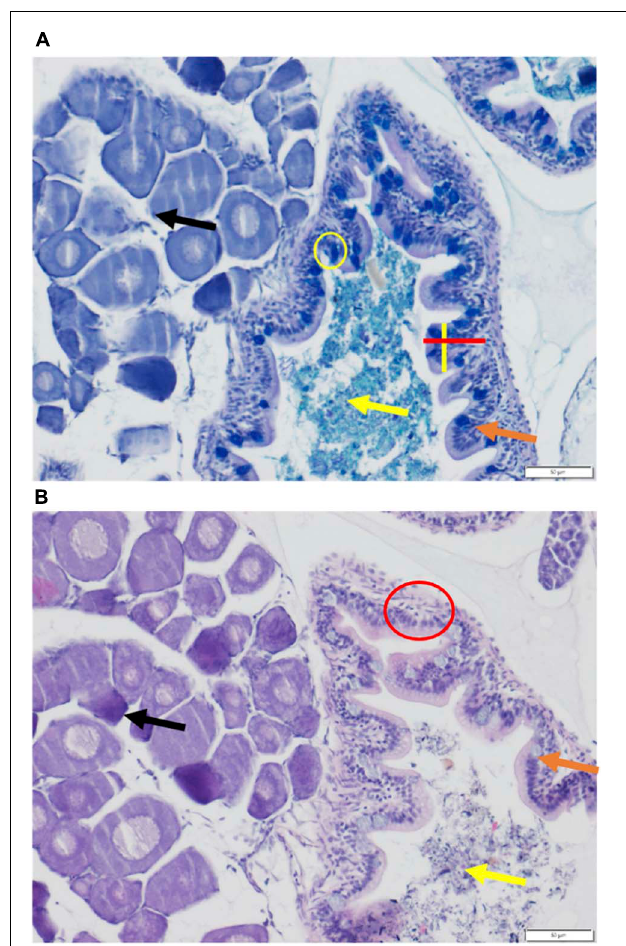
FIGURE 2 | Stained histological sections of control (0 fibers/fish/day) larval medaka hindgut. (A) AB-PAS stained hindgut. Red line indicates a measurement of microvilli length. Yellow line indicates a measurement of microvilli width. Yellow circle encompasses goblet cell. Orange arrow indicates microvilli; yellow arrow indicates gut lumen/gut contents; black arrow indicates gonadal tissue. (B) H&E stained hindgut. Red circle encompasses example area assessed for leukocyte migration/inflammation. Orange arrow indicates microvilli; yellow arrow indicates gut/lumen contents; black arrow indicates gonadal